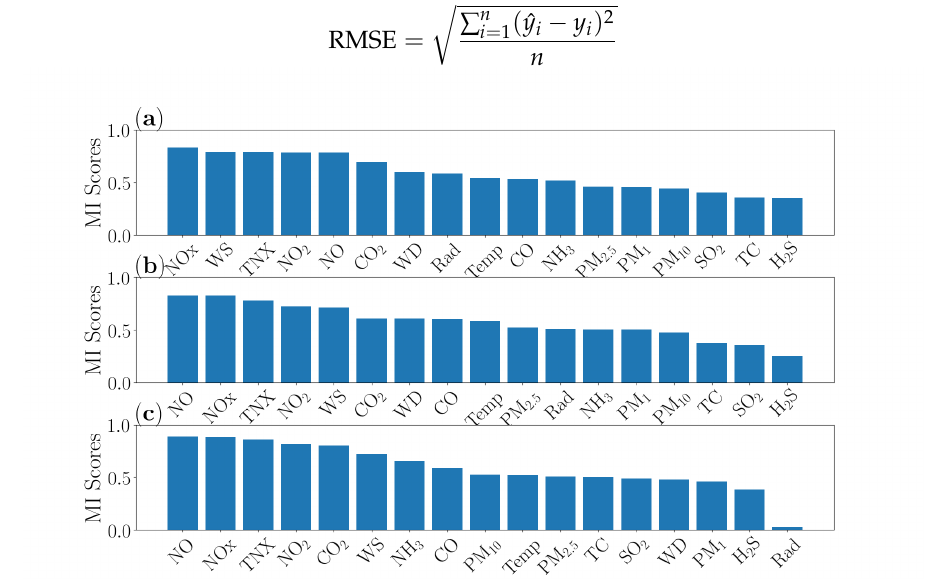
Figure 7. Mutual information level between ozone concentration and other measured variables on full day ( a ), day only ( b ) and night only ( c